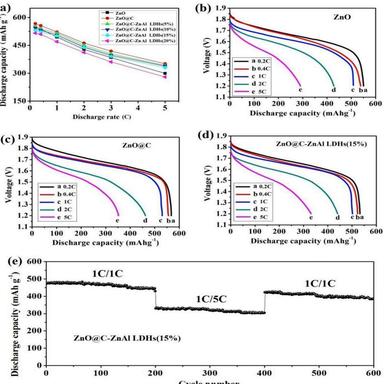
(a) Rate performance of the ZnO, ZnO@C, ZnO@C-ZnAl LDHs composites electrodes at various discharge rates (0.2 C-5 C); Typical discharge curves of the ZnO, ZnO@C, ZnO@C-ZnAl LDHs(15%) electrodes at various discharge rates:(b) ZnO, (c) ZnO@C, (d) ZnO@C-ZnAl LDHs(15%); (e) Cyclic performance of the asprepared ZnO@C-ZnAl LDHs(15%) electrode by cycling at charge/discharge rates of 1C/1C for 400 cycles and 1C/5C for 200 cycles.